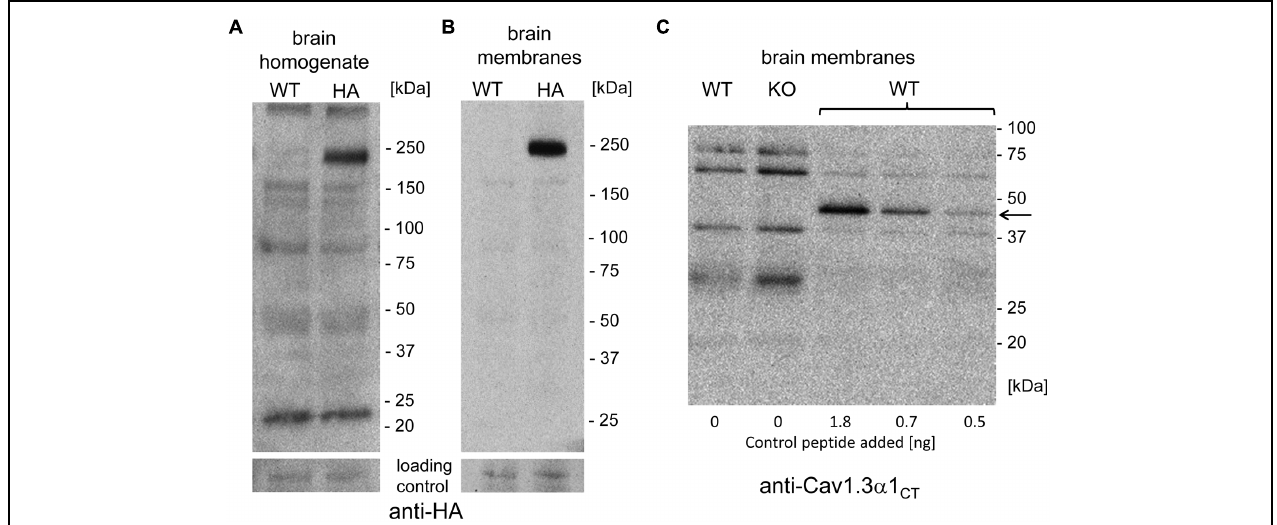
FIGURE 4 | Absence of smaller C-terminally–derived Cav1.3 α 1 fragments in WT and Cav1.3DCRD HA / HA brain preparations. (A) Mouse brain homogenate (100 μ g of protein/lane) prepared from WT or Cav1.3DCRD HA / HA (HA) mice were separated on 4–15% gradient SDS-PAGE and immunostained with anti-HA antibody. The blot was overexposed to also visualize less abundant smaller fragments. in separate experiments α 1- associated HA-immunoreactivity could be detected with only 10% (10 μ g/lane) of the protein amount used ( n = 3)